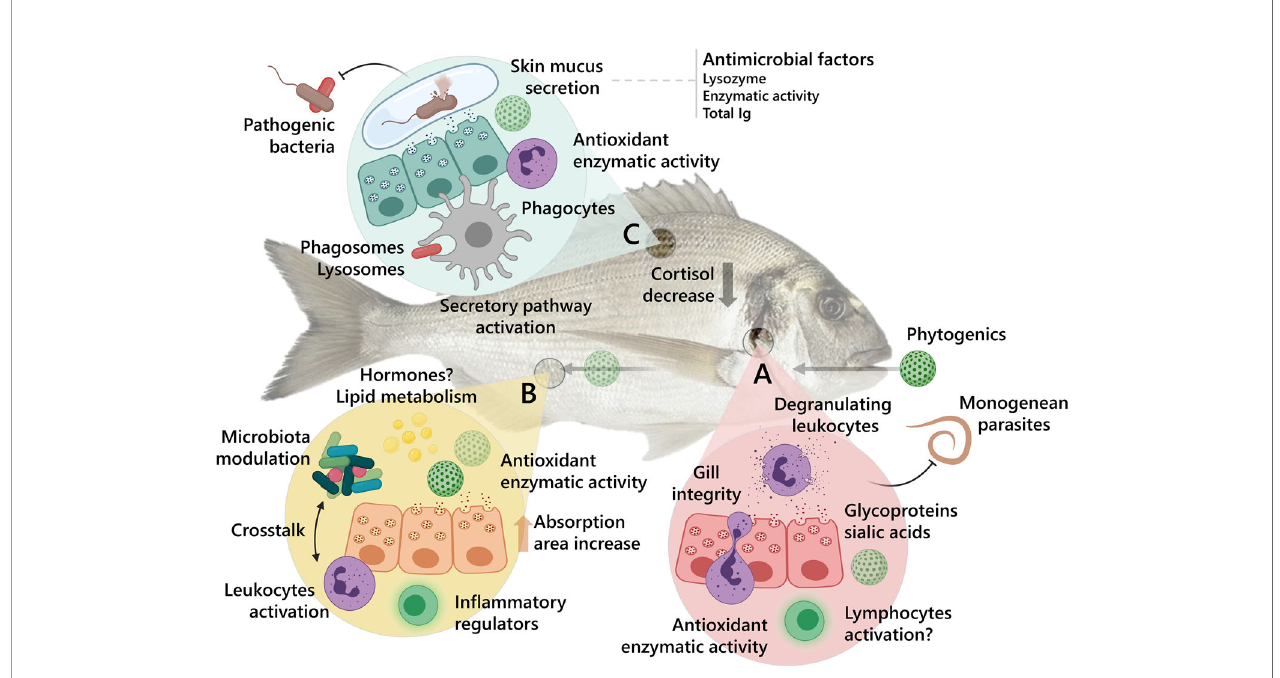
FIGURE 2 | Summary of the proposed mode of response induced by phytogenic bioactive compounds in fi sh mucosal tissues. The effects against representative types of common pathogens on the most studied mucosal-associated lymphoid tissues in fi sh so far are represented in the fi gure. (A) Gills. (B) Gut. (C) Skin. Gilthead seabream ( S. aurata ) was used in the fi gure as a representative aquaculture-relevant fi